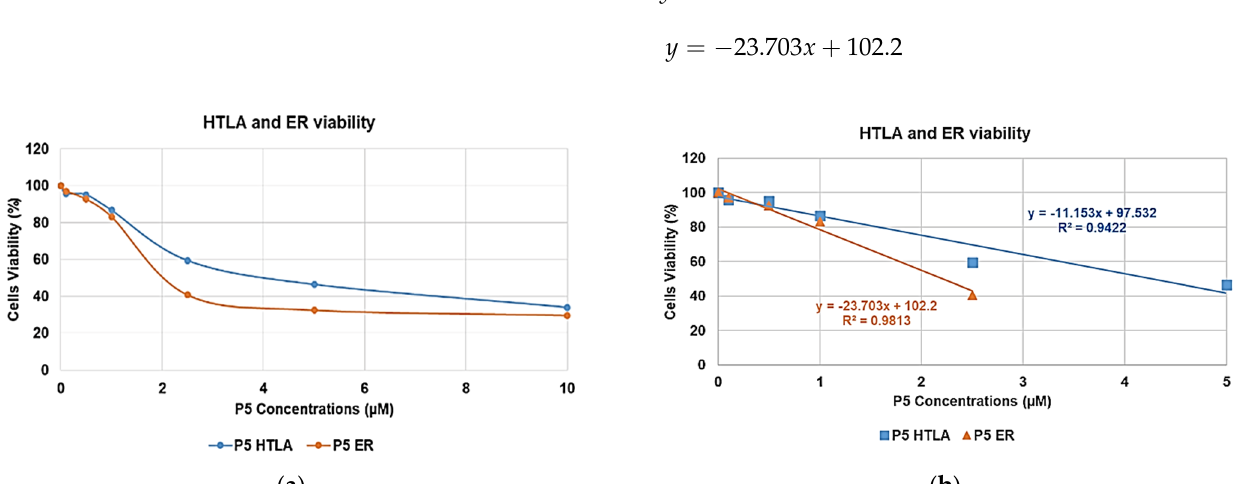
Figure 6. Dispersion graphs of the viability of NB cell populations exposed to increasing concentration of P5 (0 – 10 µM) for 24 h ( a ); linear regressions associated with the dispersion graphs of the viability of HTLA-230 cells (HTLA) up to 5 µM and of HTLA-ER (ER) cells up to 2.5 µM ( b ).